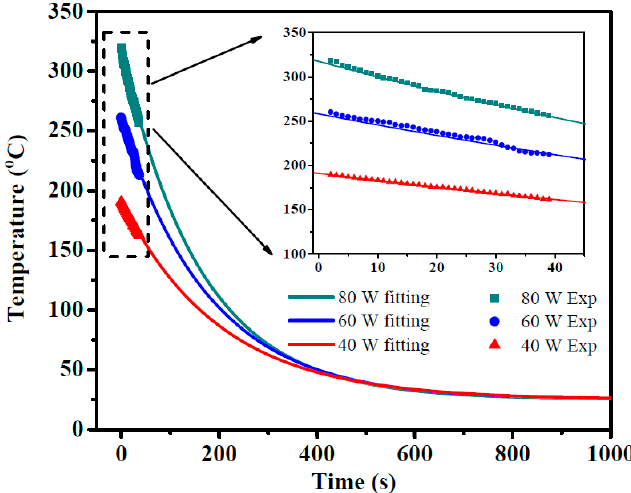
Figure 4. The temperature of electrode decreasing with time and fitted by Newton’s law of cooling.